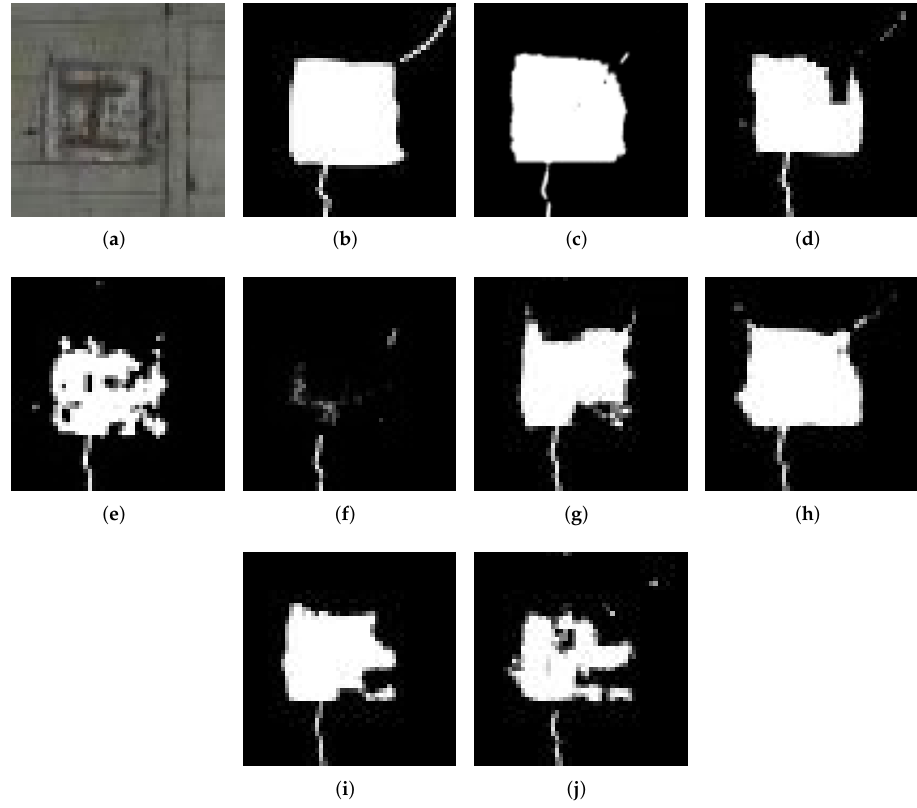
Figure 7. Example of the result in peeling detection. ( a ) Original image. ( b ) Ground Truth. ( c )